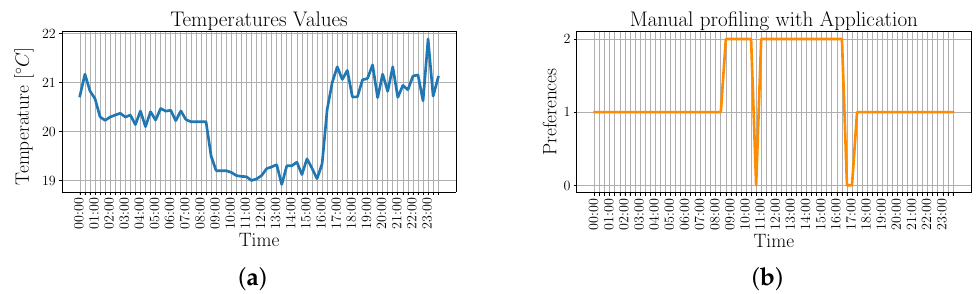
Figure 7. Temperature values and identified profiles for the manually-set profile. Note that each profile corresponds to a different location. ( a ) Temperature values w.r.t. time; ( b ) Identified profile w.r.t. time.